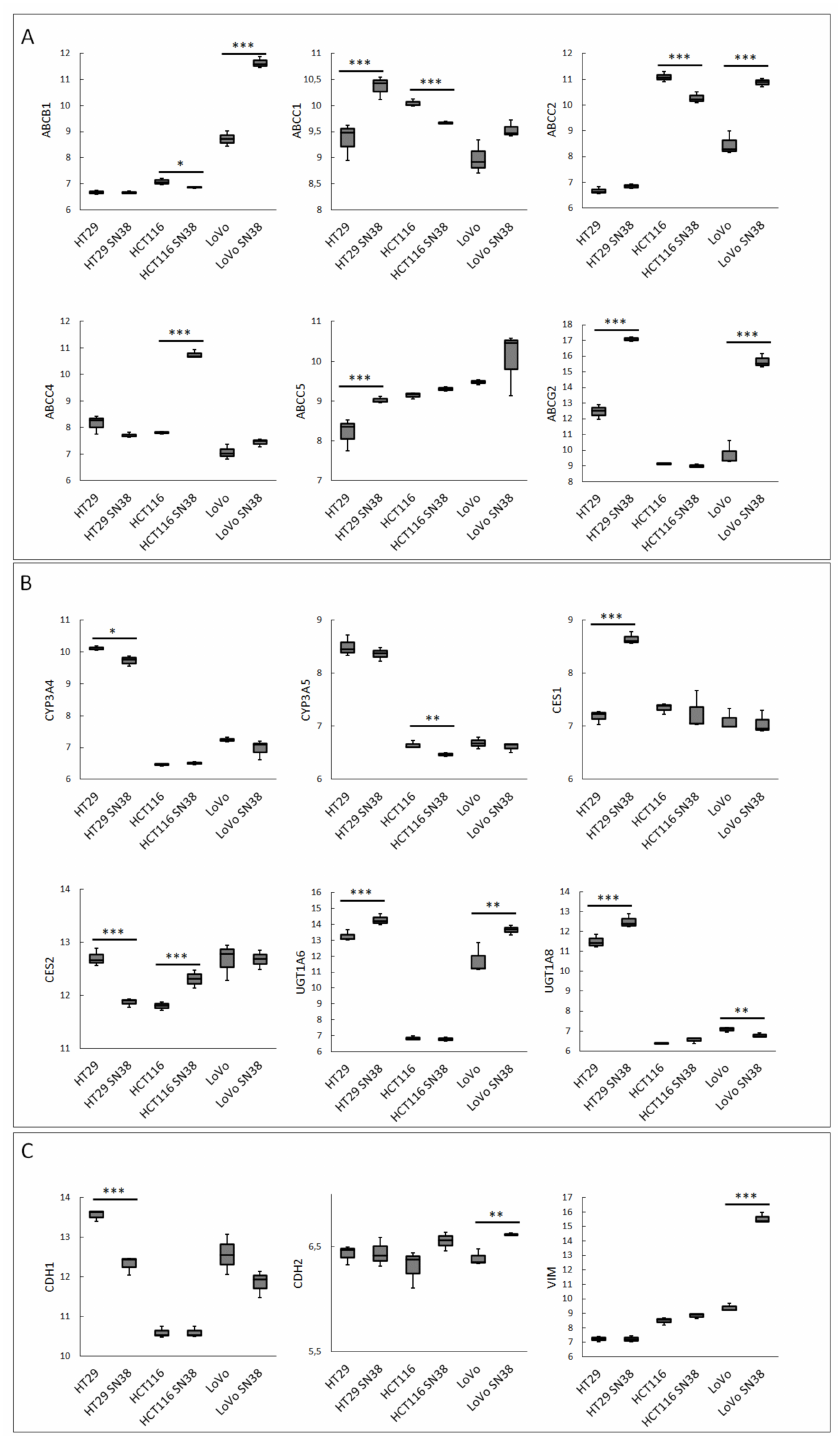
Figure 1. The expression levels of irinotecan-resistance-related proteins in CRC cell lines. Data were obtained from the GEO database of GSE42387 (using GPL16297 Agilent-014850 Whole Human Genome Microarray 4x44K G4112F platform). Changes in mRNA expressions (Y-axis) of ( A ) ABC proteins, ( B ) irinotecan-metabolism-related enzymes, and ( C ) EMT markers were measured in every cell line variant (HT29, LoVo, and HTC116 and their irinotecan (SN-38)-resistant variants HT29 SN-38, LoVo SN-38, and HTC116 SN-38) in triplicate. Normality test (Shapiro–Wilk’s) followed by Mann–Whitney U test (for not normally distributed data) or T-test (for normally distributed data); * p < 0.05, ** p < 0.005, and *** p <